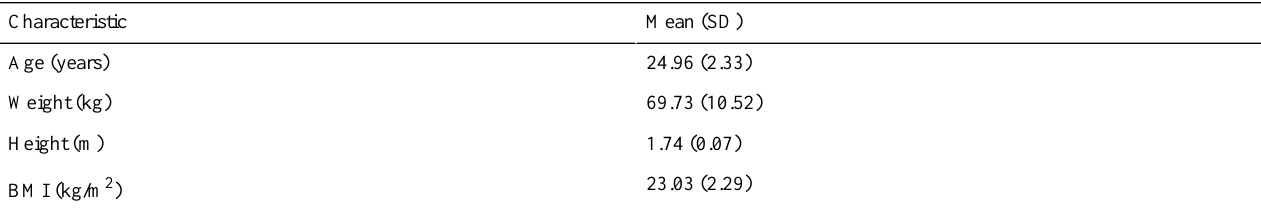
Table 1. Characteristics of the sample (N=20).